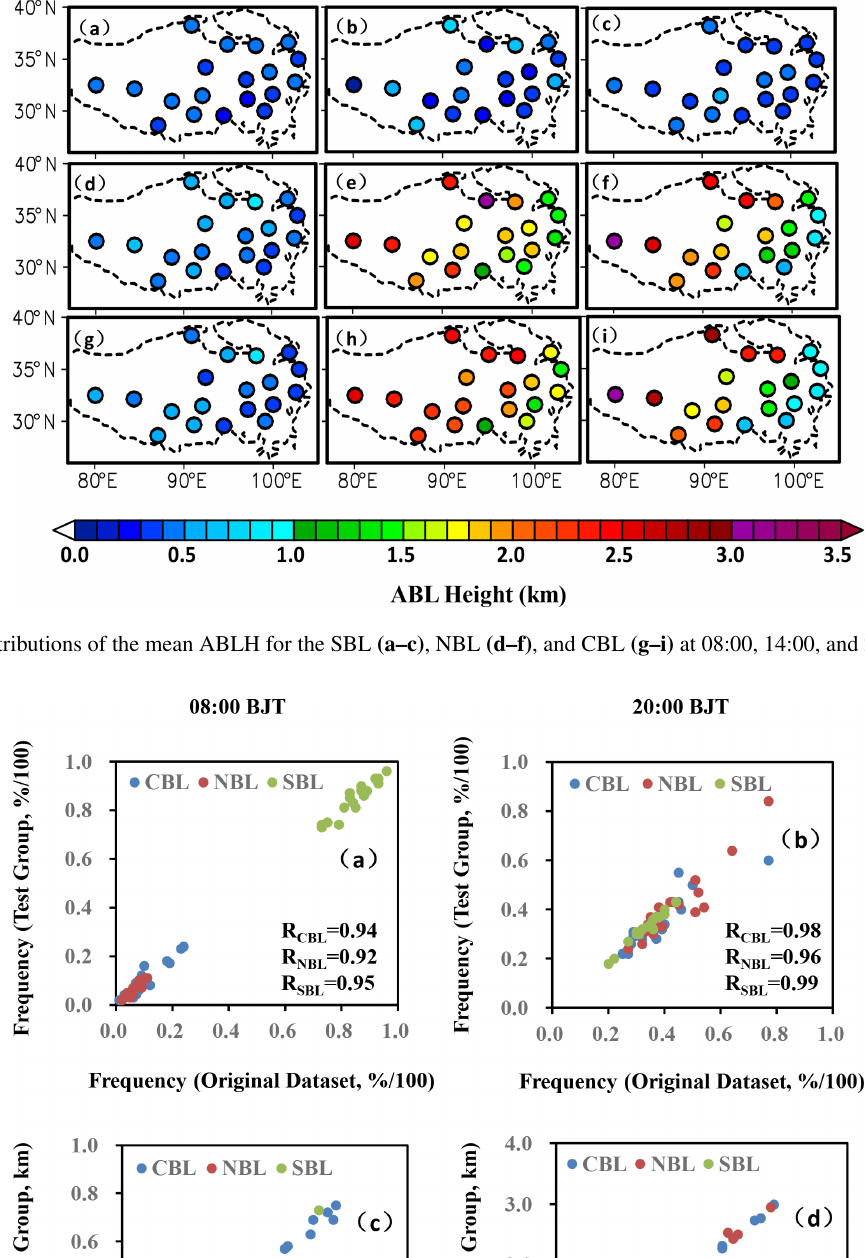
Atmos. Chem. Phys., 21, 5253–5268, 2021